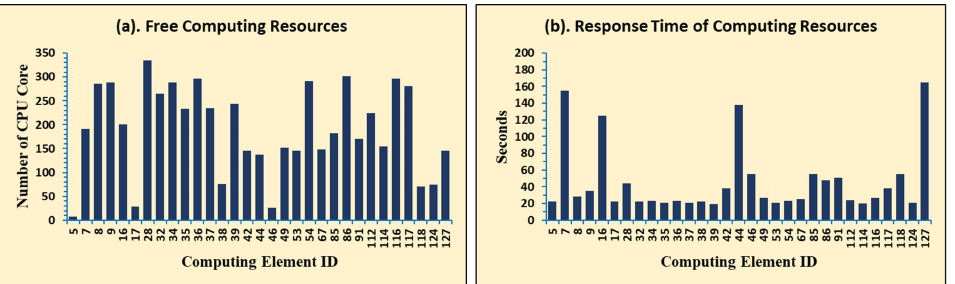
Figure 2. Resource Capacity and Response Time of Each CE on BIOMED